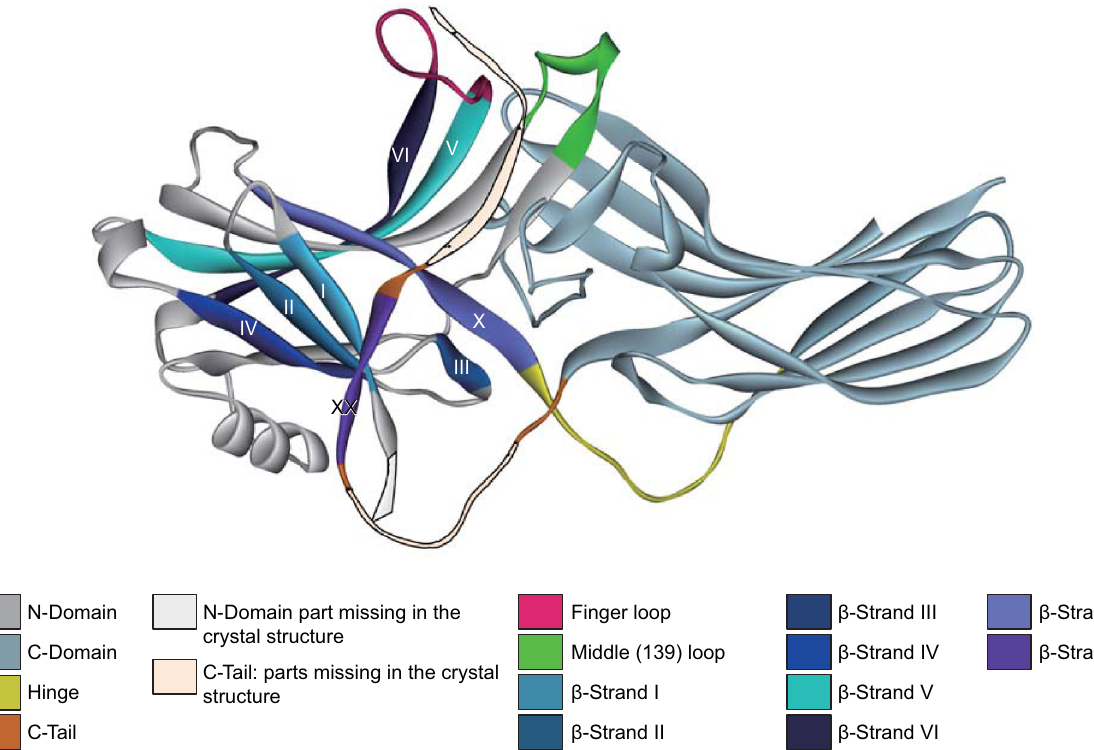
Figure 1. Arrestins structure and structural elements. The structure of arrestin-2 is shown, with main structural elements color- coded, as follows: N-domain, gray; C-domain, teal; inter-domain hinge, yellow; the part of the C-tail resolved in crystal structures, magenta; fi nger loop, pink; middle loop (termed 139-loop in arrestin-1), green. The part of the N-domain (the N-terminus) and of the C-tail that are not resolved in any crystal structure were added manually and are shown as light grey and light pink, respectively, with black outline. β -strands I, II, III, IV, V, VI, X, and XX are shown in indicated colors and labeled with roman numerals on the structure. Note that β -strand XX, anchored to β -strand I and - α -helix via three-element interaction (see Fig. 2A), includes virtually the whole part of the C-tail resolved in crystal